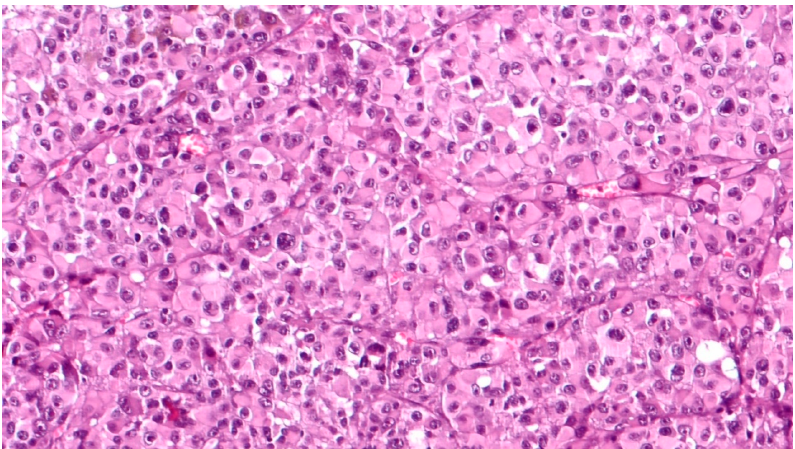
Figure 3. High magnification showing epithelioid cell type, poorly pigmented, choroidal melanoma, composed of polygonal cells with abundant, eosinophilic cytoplasm, distinct cell borders and large nuclei with conspicuous nucleoli (hematoxylin and eosin; original magnification 200×). Appl. Sci. 2020 , 10 , x FOR PEER REVIEW